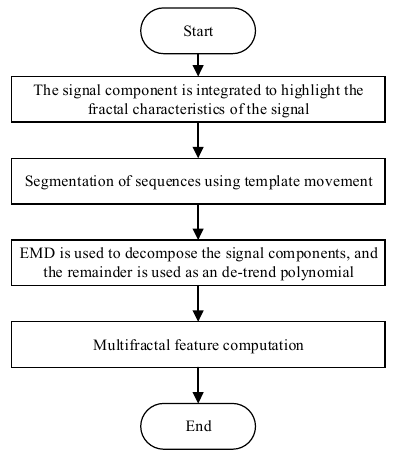
Figure 1. Flowchart of multifractal analysis.